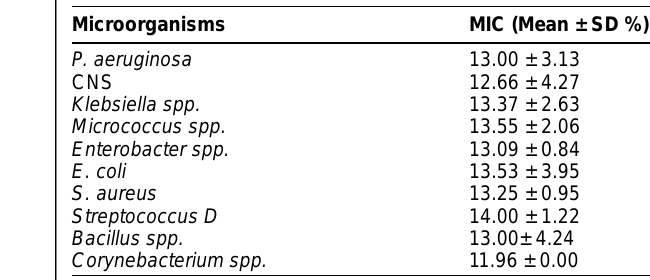
Table-2: Antimicrobial activity of honey against bacteria isolated from subclinical mastitis